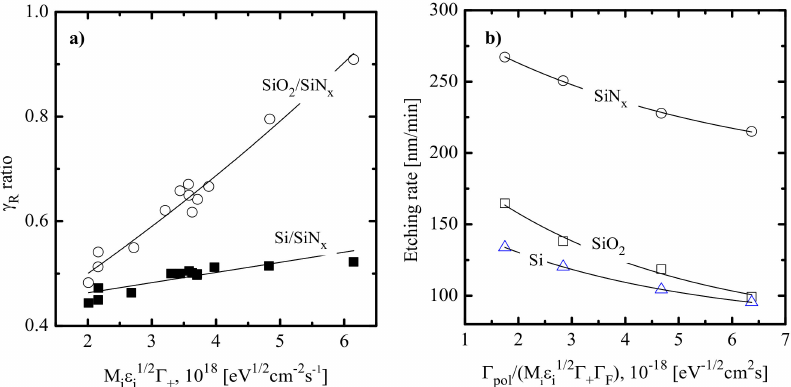
Figure 5. Correlations between gas-phase parameters and heterogeneous process characteristics for SiN x , SiO 2 and Si in C 4 F 8 + Ar plasma. In ( a ): effective reaction probability ratios vs. parameter which traces the intensity of ion bombardment. In ( b ): etching rates vs. parameter Γ pol / which traces the thickness of polymer film.